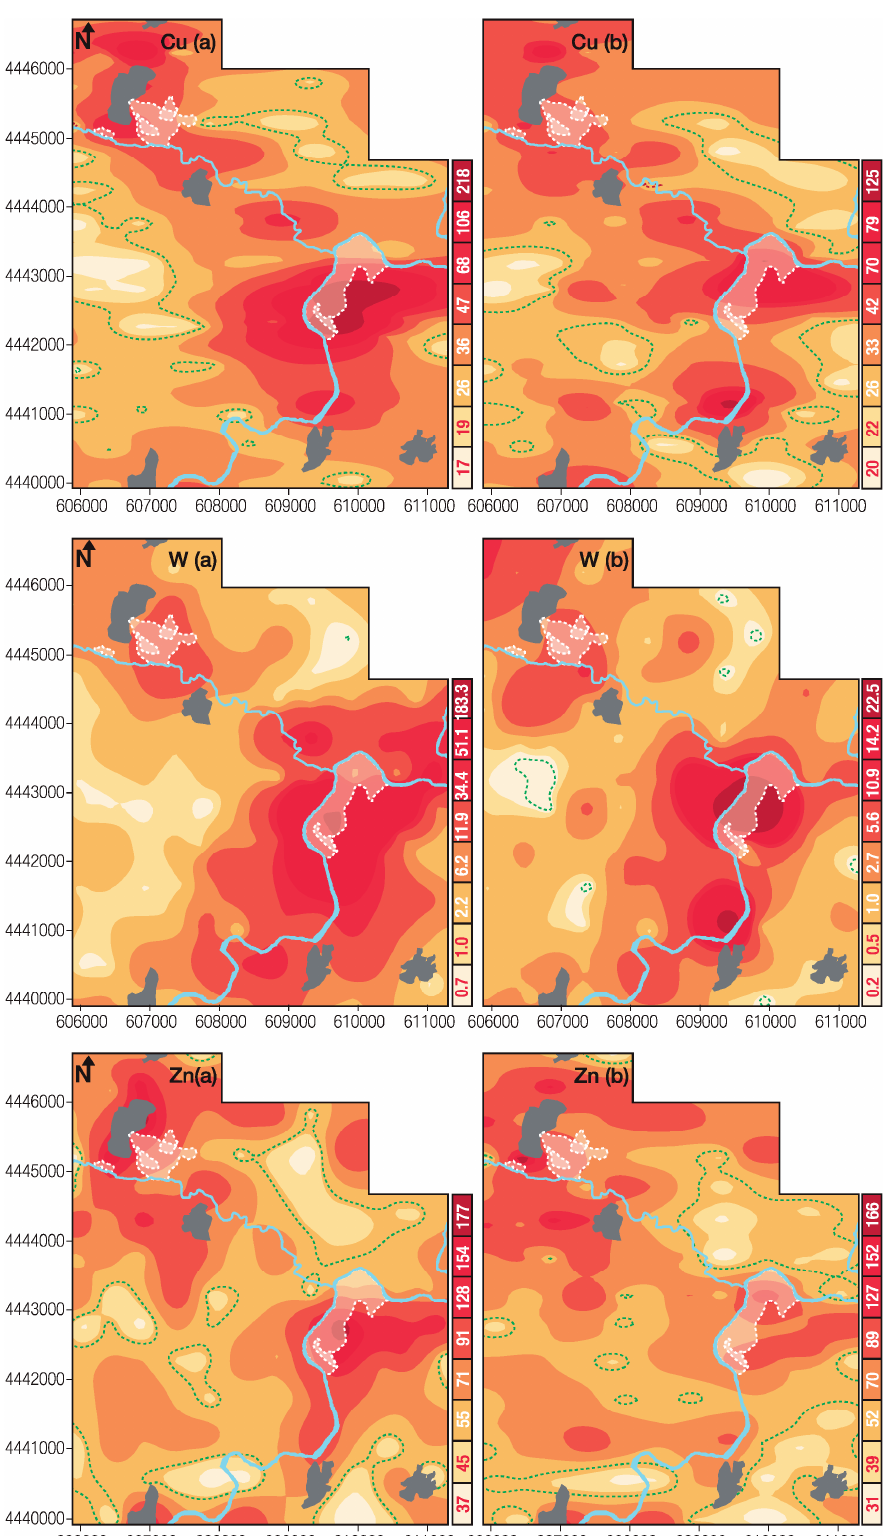
Figure 4. Spatial distribution of Cu, W, Zn (mg·kg − 1 ) values for topsoil ( a ) and subsoil ( b ). Percentile class limits at P5, P10, P25, P50, P75, P90, P95 and P97.5. The green dashed lines represent the elements background levels. In blue are represented the main water courses, in grey the villages and in white the main tailings and